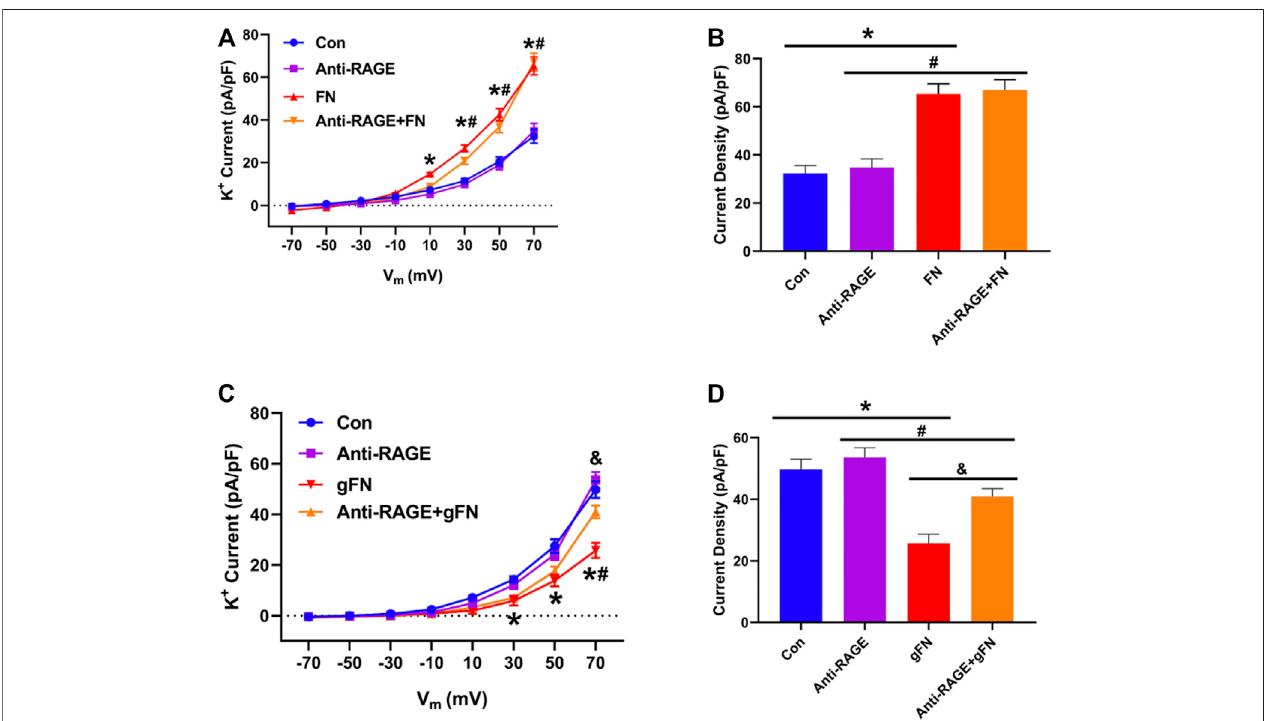
FIGURE7| Effectofafunctionblockinganti-RAGEantibodyonFNandgFN-mediatedchangesinwholecellK + current.Panel (A) Groupdata( n =10 – 16)showing the effect of anti-RAGE antibody on current density — voltage relationships under control conditions and in response to FN. Panel (B) Summary of data from Panel (A) recordedatavoltagesteppotentialof+70 mV.Anti-RAGEantibodyshowsnoeffectonthestimulatoryactionofnativeFNonwholecellK + current.Resultsareshownas mean ± SEM; n = 9 – 13 cells per group. * p < 0.05, Control vs. FN; #, Anti-RAGE vs. Anti-RAGE + FN. Panel (C) Group data ( n = 12 – 15) showing the effect of anti- RAGE antibody on current density — voltage relationships under control conditions and in response to gFN. Panel (D) Summary of data from Panel (C) at a holding potential of +70 mV. Anti-RAGE antibody signi fi cantly attenuated the inhibitory effect of gFN on whole cell K + current. * p < 0.05, Control vs. gFN; # p < 0.05, Anti-RAGE Vs. Anti-RAGE + gFN; & p < 0.05, gFN vs. Anti-RAGE + gFN. Results are shown as mean ± SEM.